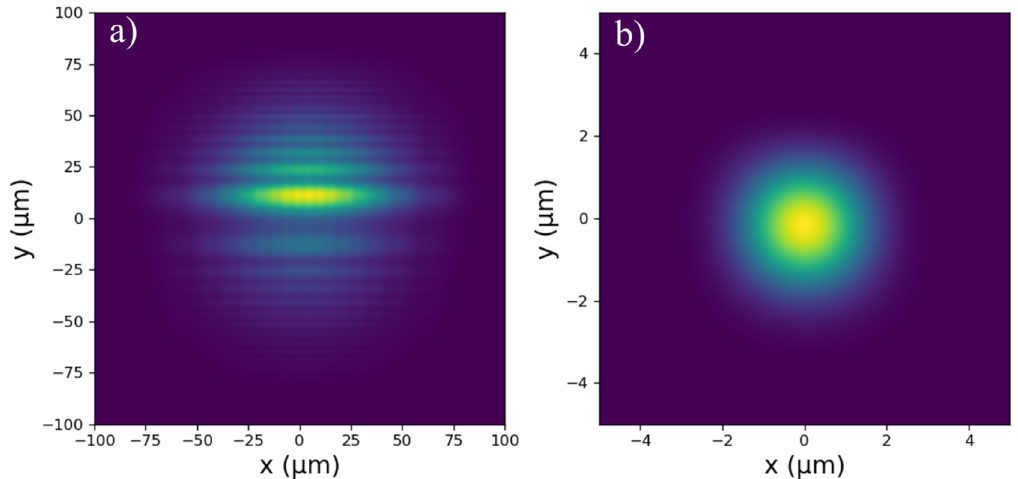
Figure 5. ( a ) Simulated transverse beam profile on the plane 0.1 m downstream the SDL and 1.9 m upstream the focus. ( b ) Simulated transverse beam profile on the focus plane when the attenuator is employed.